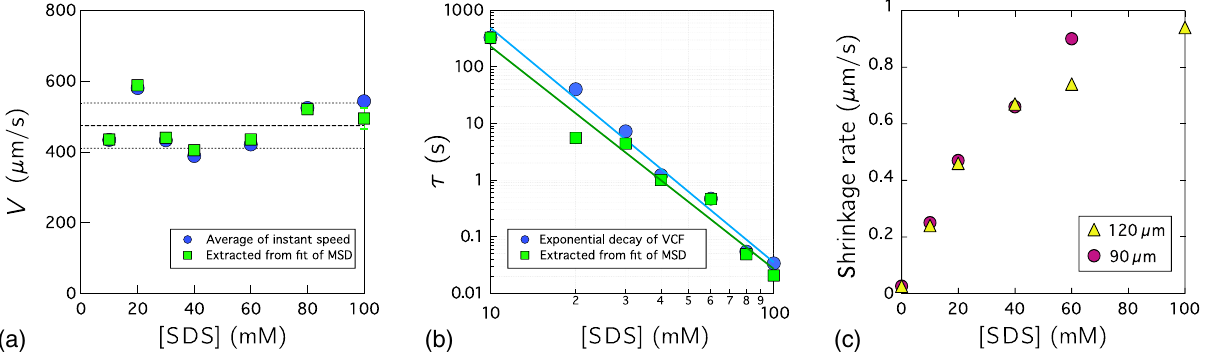
FIG. 7. Effect of surfactant concentration on motility. (a) Instantaneous speed V , estimated directly from trajectories (circles) or the MSD fits of Eq. (3) (squares), is largely independent of [SDS]. (b) Persistence time τ , from the fits and the values extracted from the velocity correlation function C ð Δ t Þ , sharply decays with [SDS] with a heuristic power-law fit τ ¼ 6 × 10 6 ½ SDS (cid:3) − 4 . (c) The rate of droplet dissolution increases nonlinearly as a function of SDS concentration over the experimental range.